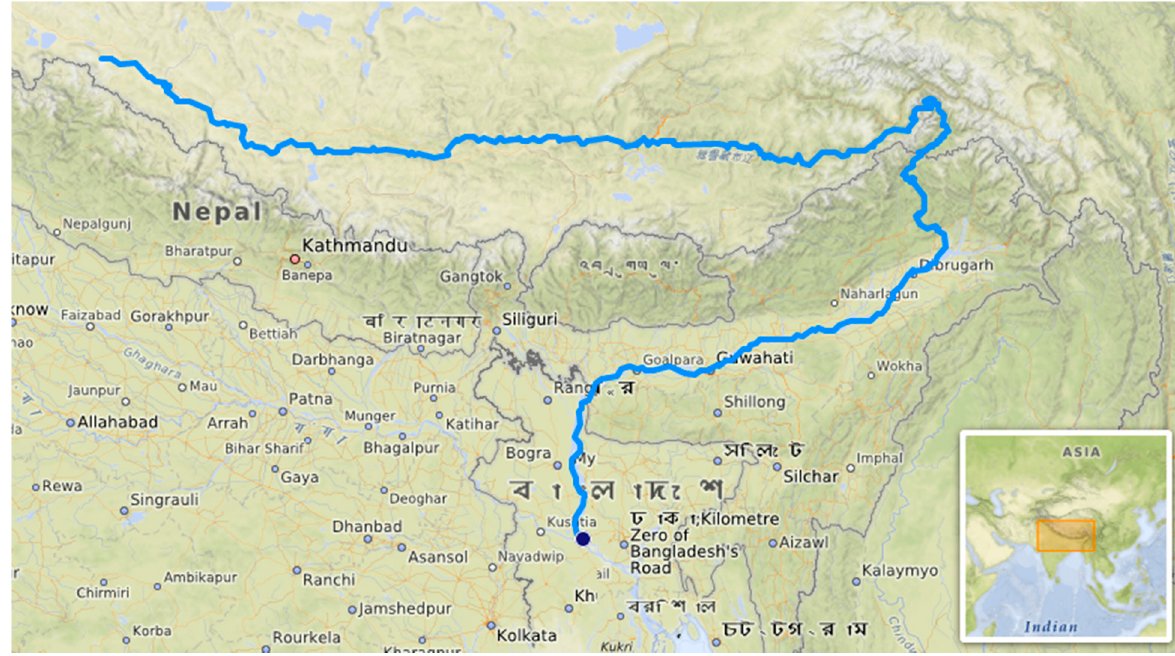
Figure 1. Brahmaputra River map (https://en.wikipedia.org/wiki/Brahmaputra_River#/media/File:Brahmapoutre.png (accessed on 15 September 2021).